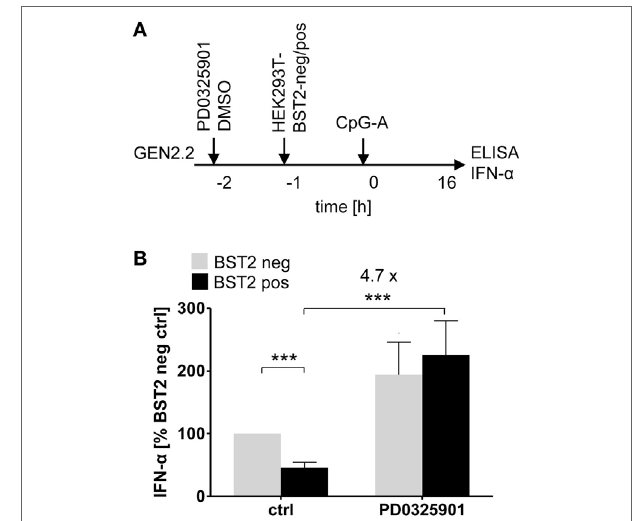
FigUre 5 | Effect of MEK1/2 inhibition on the blockade of IFN- α by co-culture of GEN2.2 cells with BST2-expressing HEK293T cells. (a) Experimental outline. In total 10 5 GEN2.2 cells pretreated with 1 µM PD0325901 were added to a monolayer of 10 5 control HEK293T cells or to